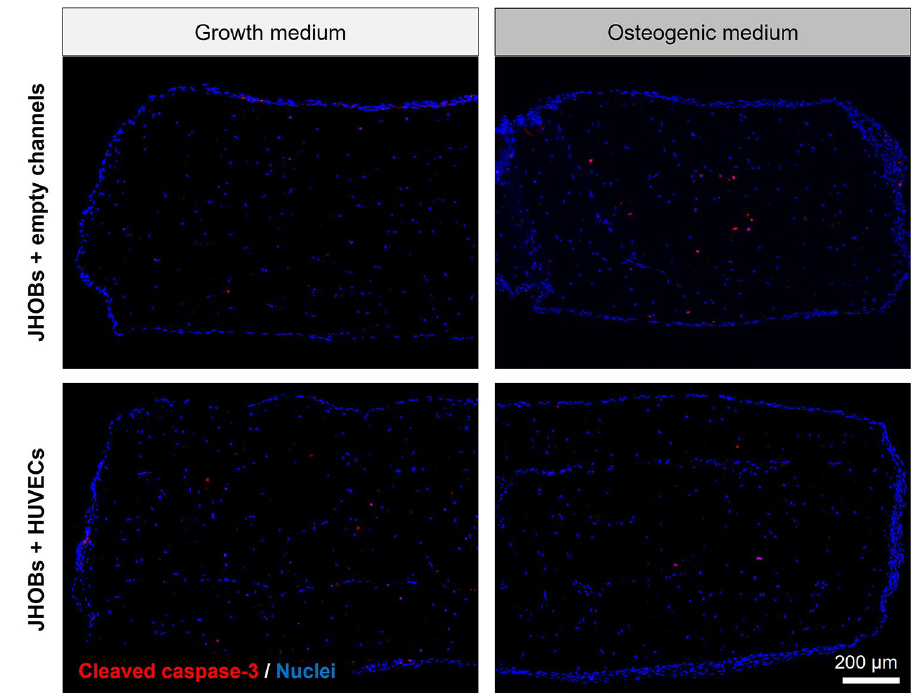
Figure 5. Immunohistological staining for apoptotic cells. Cell-laden constructs containing JHOBs and optionally HUVECs were stained for cleaved caspase-3 after 28 days of cultivation in growth and osteogenic